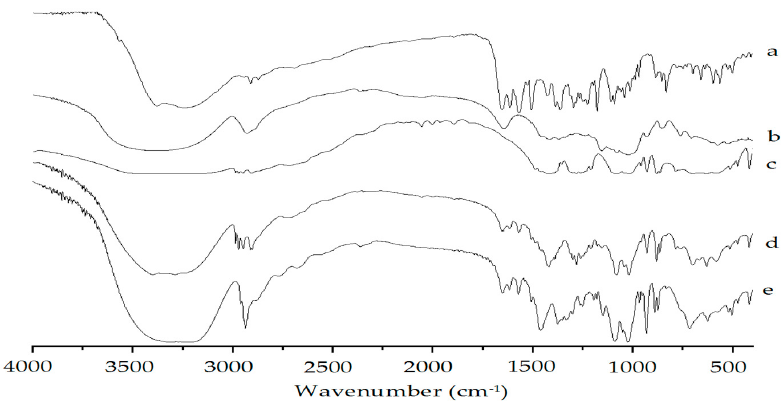
Figure 5. FTIR spectra of ( a ) raw vitexin; ( b ) poloxamer 188; ( c ) mannitol; ( d ) physical mixture of vitexin; poloxamer 188 and mannitol; and ( e ) vitexin nanoparticles.